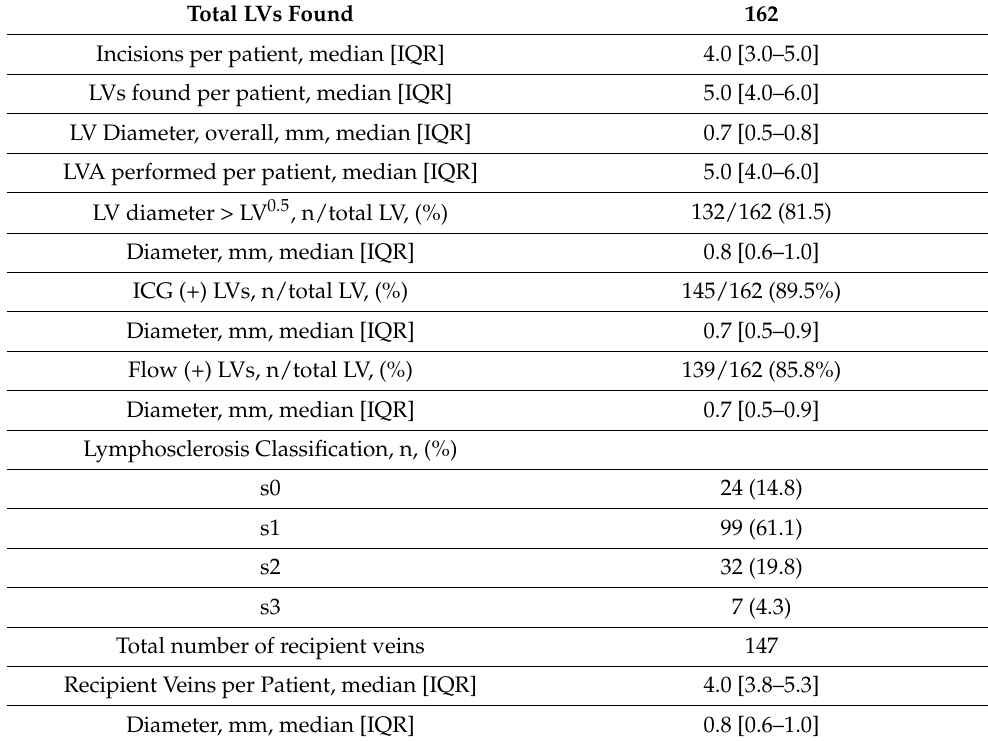
Table 2. Intraoperative